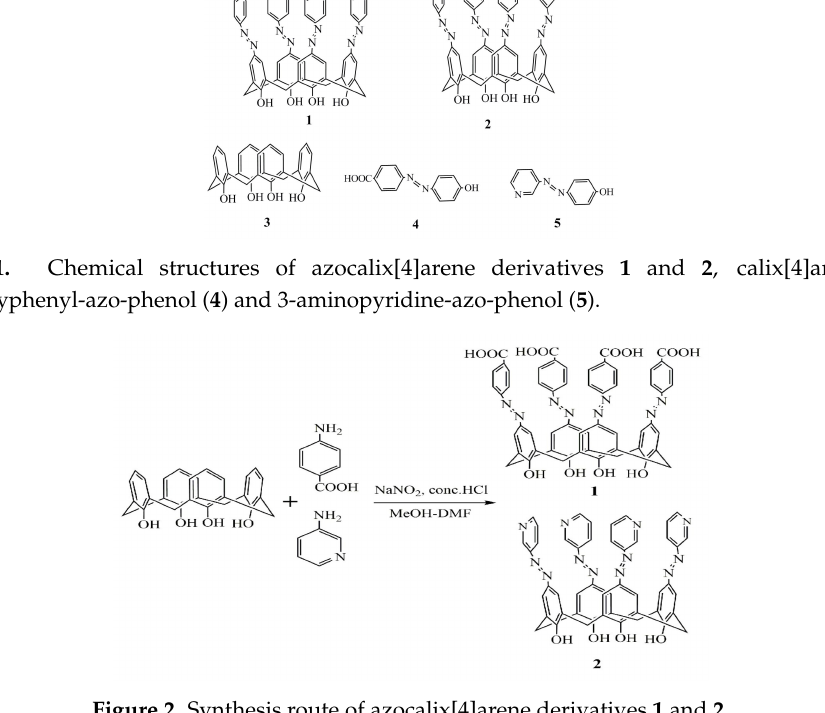
Figure 2. Synthesis route of azocalix[4]arene derivatives 1 and 2